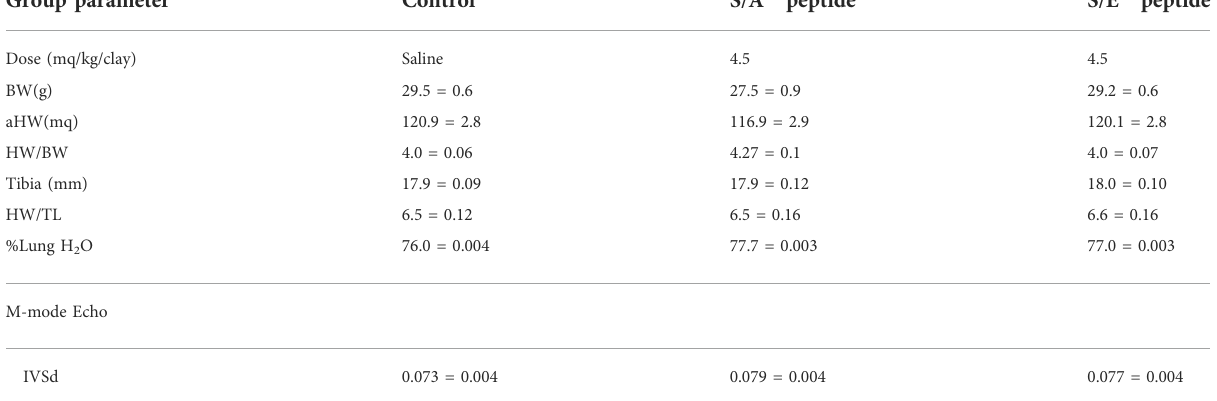
TABLE 2 Cardiac geometry and strain rate analysis determined by echocardiography in mice at 2 weeks with and without MGF E-peptide treatment. Group